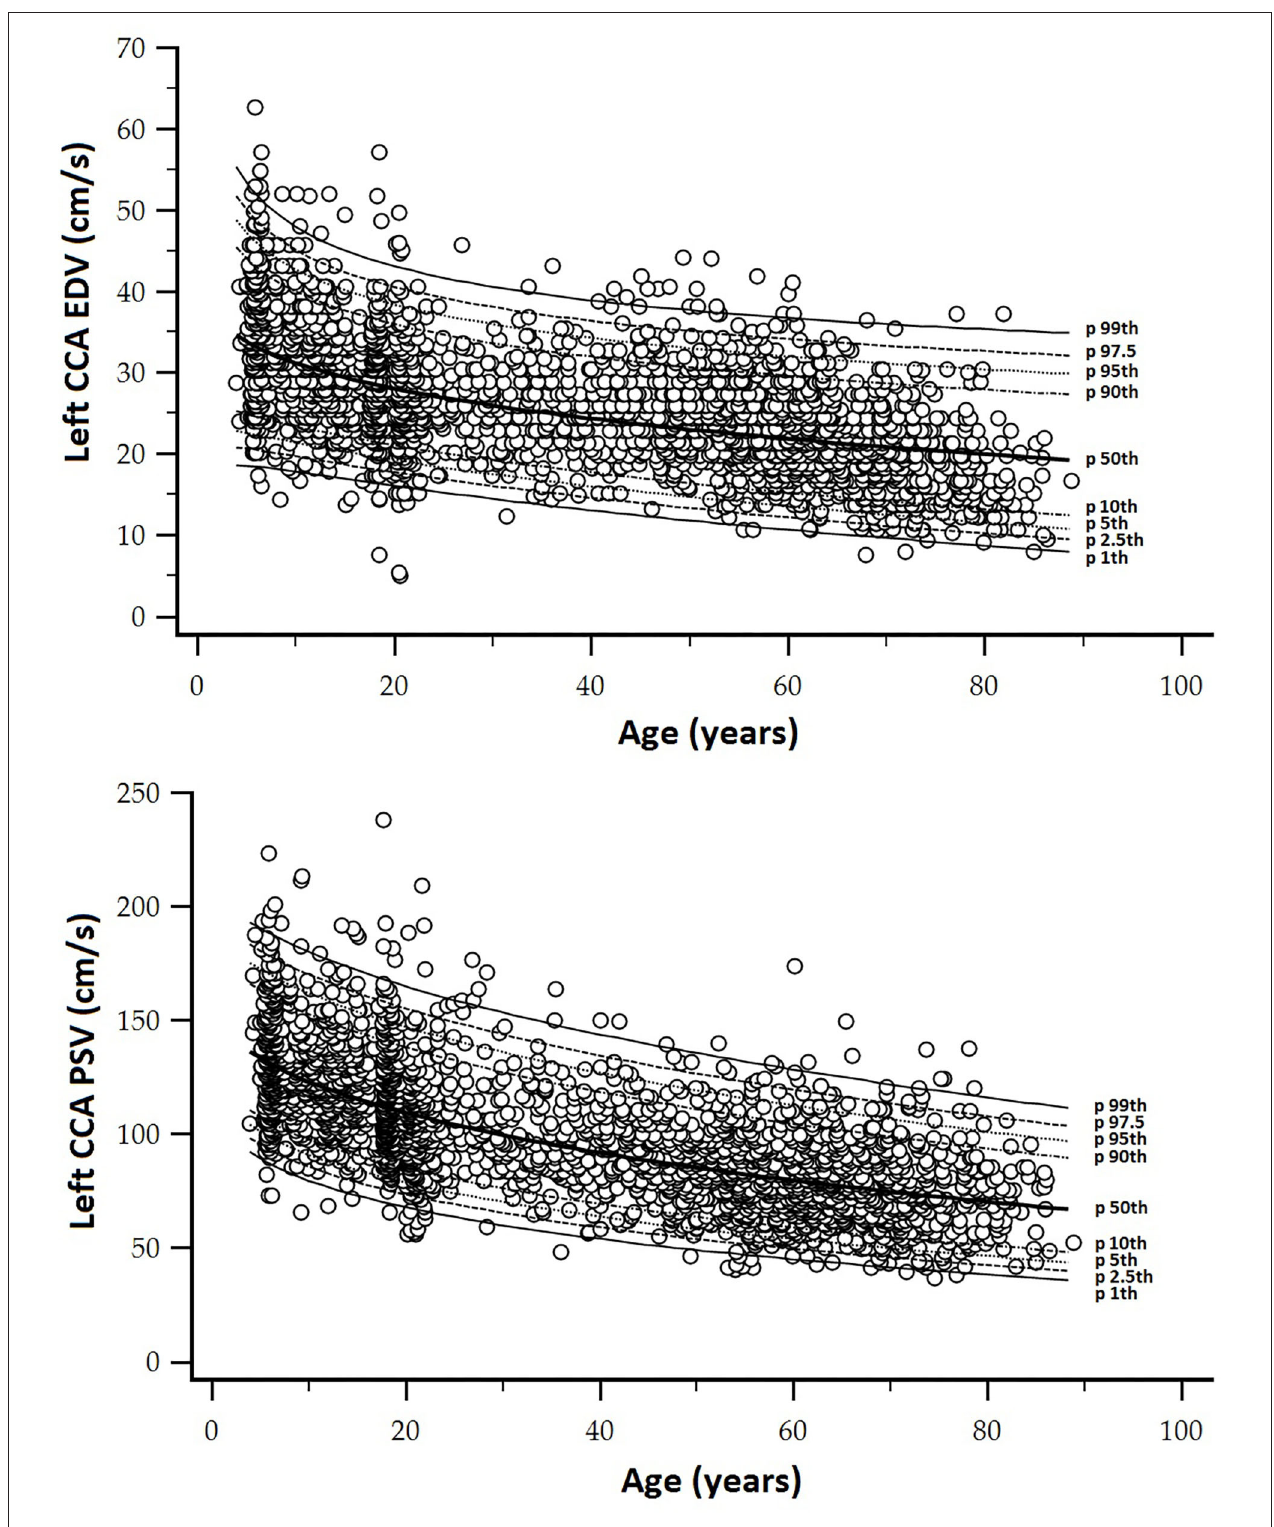
FIGURE 2 | (A) Top: Age-related profiles (1st, 2.5th, 5th, 10th, 50th, 90th, 95th, 97.5th, and 99th percentiles) for left CCA end-diastolic velocity (EDV). (B) Bottom: Age-related profiles (1st, 2.5th, 5th, 10th, 50th, 90th, 95th, 97.5th, and 99th percentiles) for left CCA peak systolic velocity (PSV).